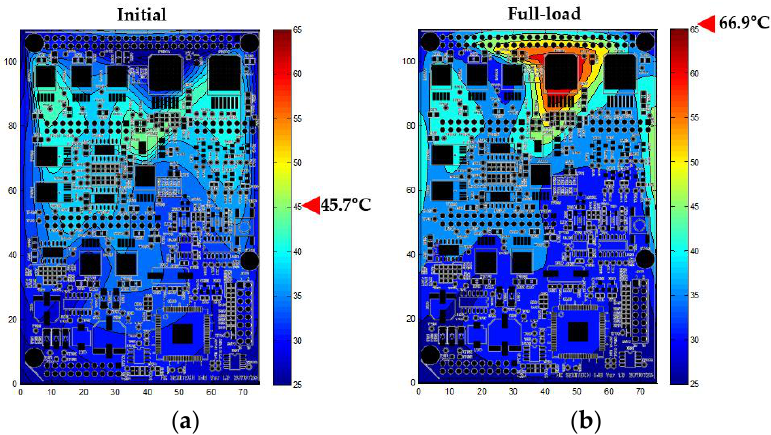
Figure 7. Temperature distribution on the SJB PCB module: ( a ) initial temperature, and ( b ) temperature after the wipers were set to high.